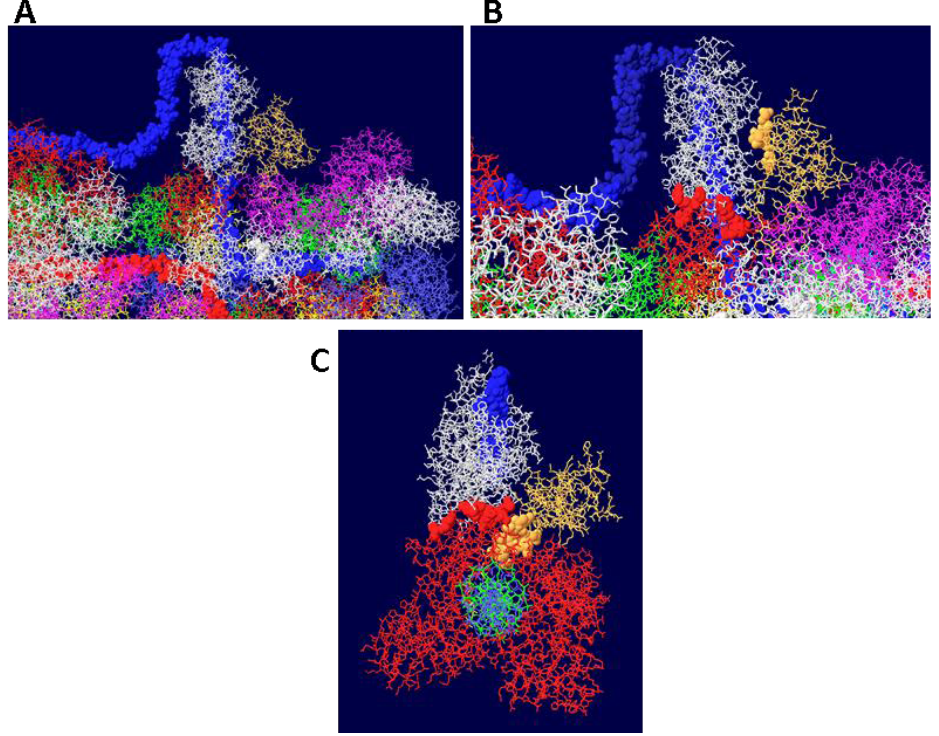
Figure 10. Details of T-RPA, J domain-topo I, and topo I-RPA interactions in the model. ( A ) the model in Figure 9 was rotated to illustrate the position of the J domain relative to an OBD monomer. The J domain (gold) lies on the surface of the purple OBD monomer. ( B ) Close-up of J domain-RPA and OBD-RPA interaction surfaces. The highlighted gold residues are those of the J domain contacting RPA and the highlighted red residues are those of the OBD monomer contacting RPA. ( C (cid:12)(cid:3) (cid:179)(cid:55)(cid:82)(cid:83)(cid:180)(cid:3) (cid:89)(cid:76)(cid:72)(cid:90)(cid:3) (cid:82)(cid:73)(cid:3) (cid:87)(cid:75)(cid:72)(cid:3) (cid:45)(cid:29)(cid:3) (cid:53)(cid:51)(cid:36)(cid:29)(cid:87)(cid:82)(cid:83)(cid:82)(cid:3) (cid:44)(cid:3) costructure model. This is approximately the same orientation as in Figure 9 but the double stranded DNA going through topo I is included here. The highlighted J domain gold residues are those that contact topo I and the highlighted red residues are those of topo I contacting